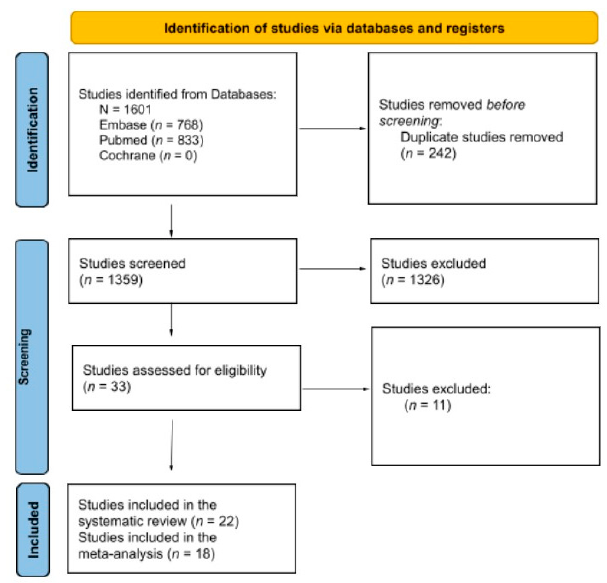
Figure 1. PRISMA flow diagram of search